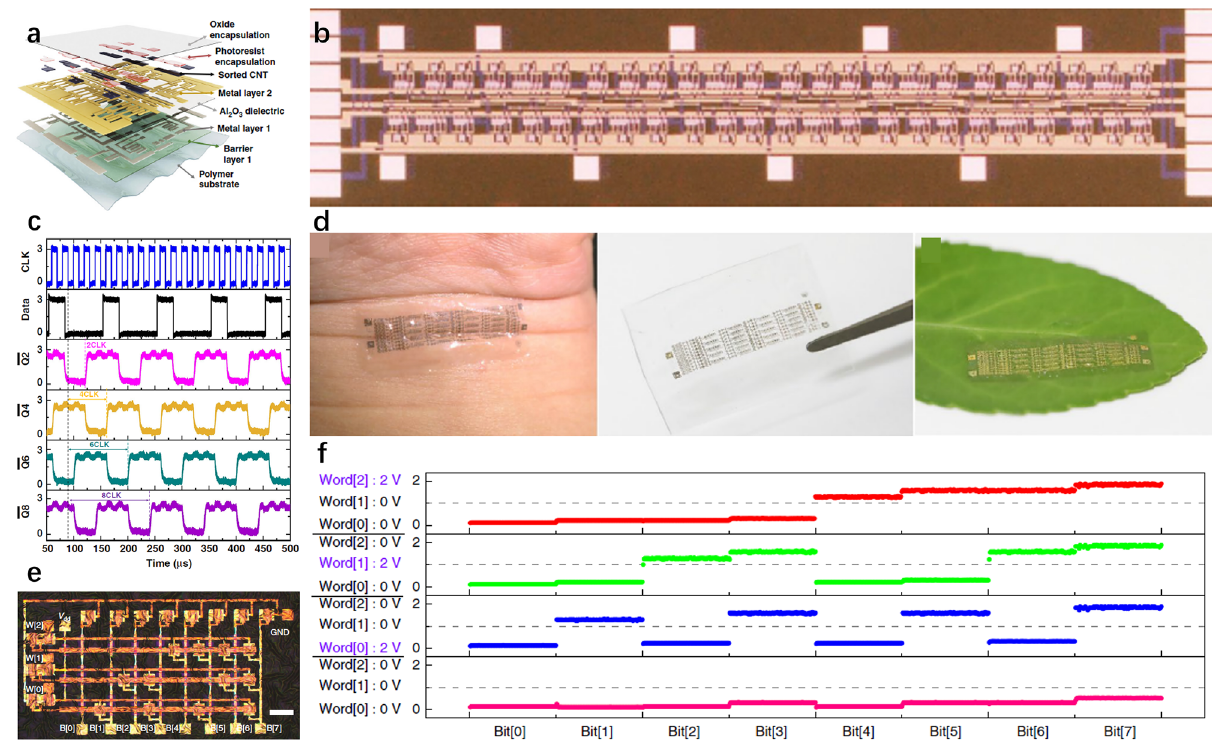
Fig. 33 Soft IC. a Layer structures of the CNT TFT. b Photograph of an eight-stage SR containing 304 CNT TFTs. c Measured waveforms of the eight-stage SR with CLK at 50 kHz and input data at 10 kHz. Reproduced with permission [392]. Copyright (2019), Springer Nature. d Images of the soft electronic devices transferred onto a wrist, a biodegradable PVA film, and a plant leaf. e Photograph of a NAND-ROM. Scale bar represents 200 μm. f 8-bit readout voltage of NAND-ROM under different 3-bit addresses of ‘000’, ‘001’, ‘010’ and ‘100’. Reproduced with permission [393]. Copyright (2018), Springer